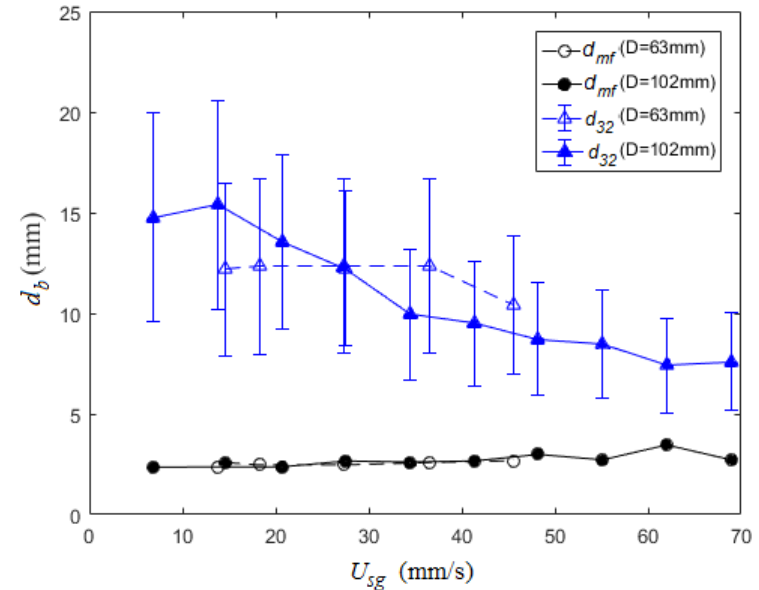
Figure 13. Bubble sizes ( d mf and d 32 ) plotted versus the superficial gas velocity with different column diameters ( d inj = 0.8 mm; P m = 600 kPa).